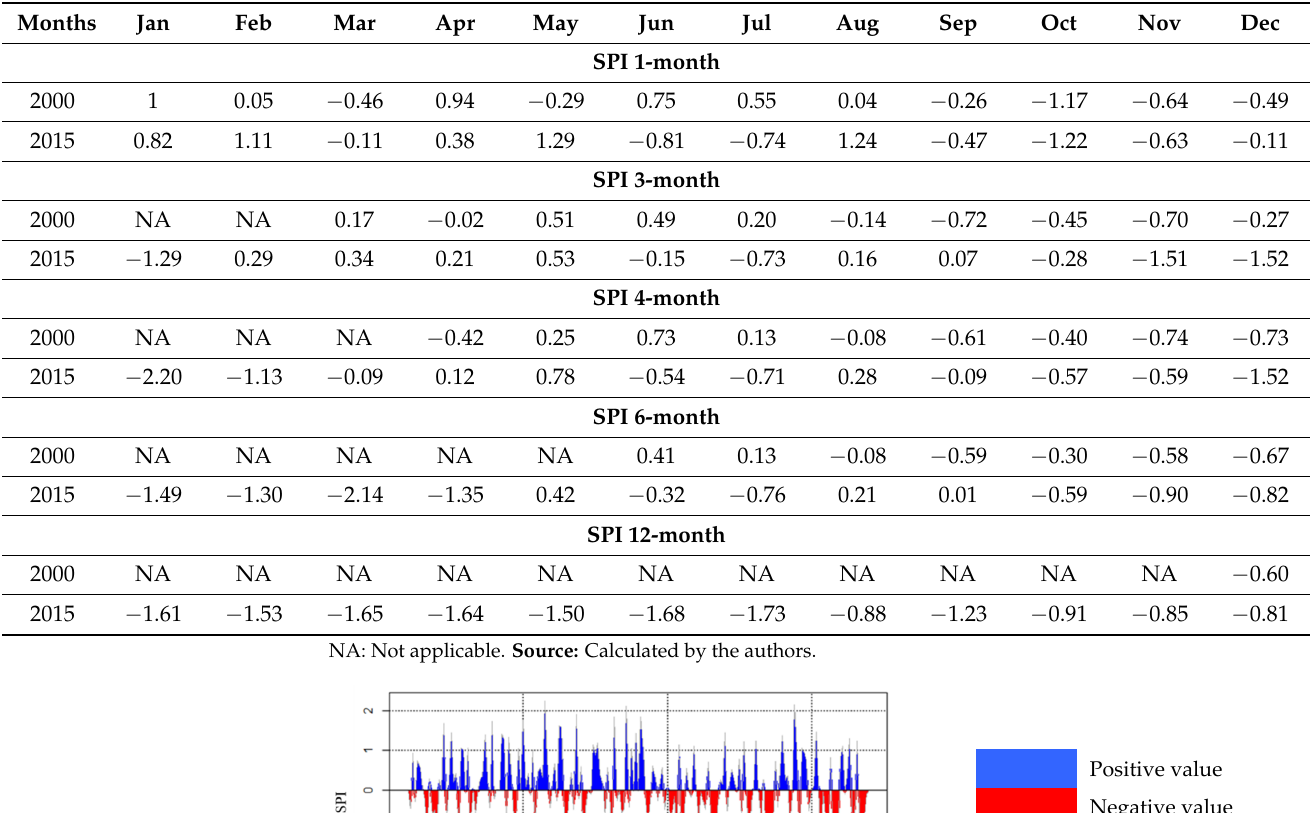
Table 5. Monthly standardized precipitation index (SPI) of the years 2000 and 2015.